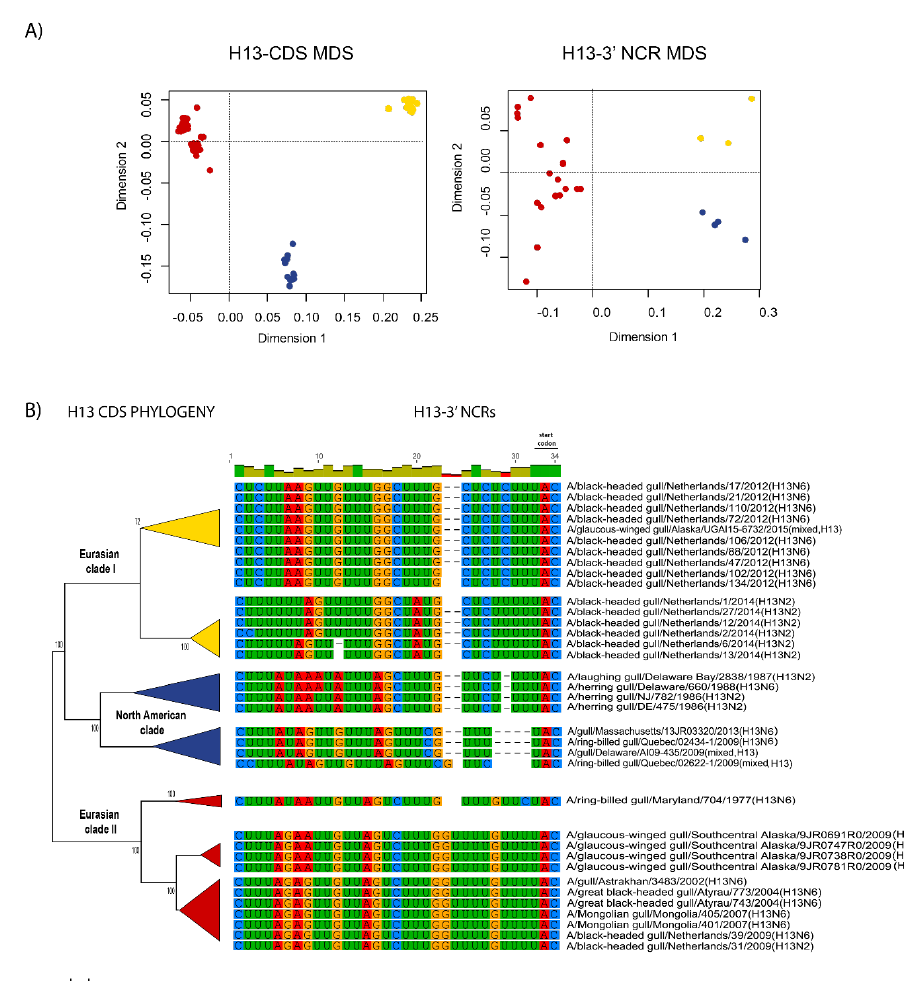
Figure 4. Relationships among H9 3 ′ NCR and CDS regions for viruses from different host species and geographic locations. The multi-dimensional analysis (MDS) scatter plots ( A ) are based on the pairwise genetic distance matrices from the multiple alignments of complete CDS regions and 3 ′ NCRs. Each dot represents a virus, colored according to their origins as indicated on the CDS-based phylogenetic tree ( B ). Alignments of the 3 ′ NCRs, shown corresponding to the genomic RNAs, from the viruses used in the analyses are next to the CDS-based neighbor-joining tree for these viruses.